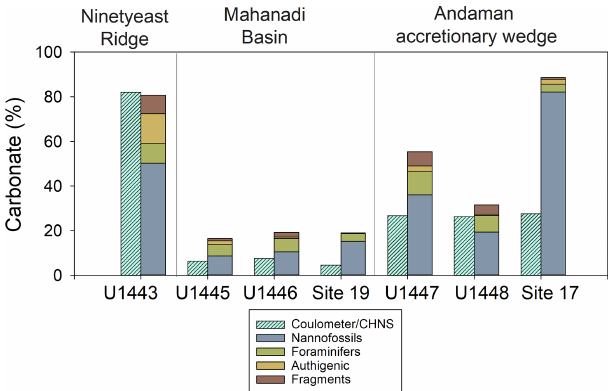
Figure 9. Comparison of total carbonate minerals (nannofossils, foraminifers, authigenic, shell fragments) by smear slide estimation to average CaCO 3 measured by carbonate coulometry for (a) IODP Expedition 353 (Clemens et al., 2016b, c, d, f, g) and NGHP Expe- dition 01 (Collett et al., 2015; Johnson et al.,